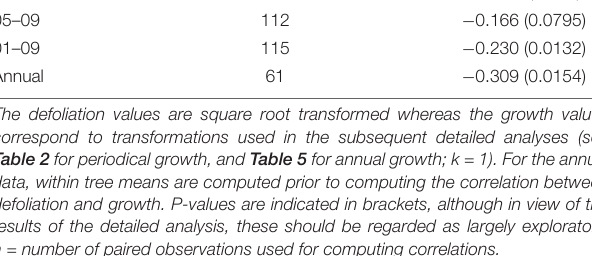
Table 2 for periodical growth, and Table 5 for annual growth; k = 1). For the annual data, within tree means are computed prior to computing the correlation between defoliation and growth. P-values are indicated in brackets, although in view of the results of the detailed analysis, these should be regarded as largely exploratory. n = number of paired observations used for computing